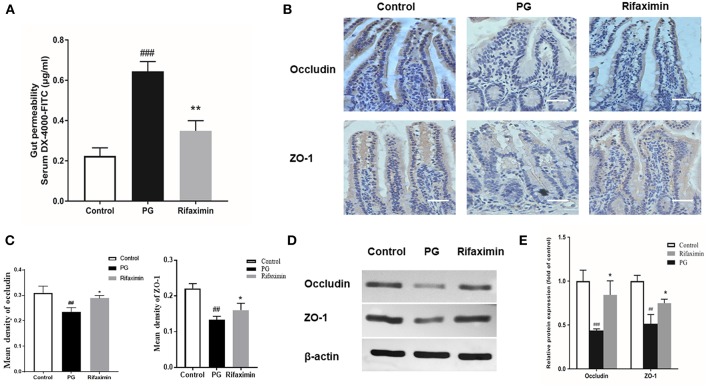
Rifaximin improves the intestinal mucosal barrier function in AS mice. (A) Gut permeability was measured by the DX-4000-FITC levels in the serum (n = 10 mice per group). (B) Occludin and ZO-1 protein in the ileum measured using immunohistochemistry. Occludin and ZO-1 positive cells were stained brown. The more intense the color, the higher the levels of occludin or ZO-1protein (Scale bar is 50μm). (C) Representative staining intensities of occludin and ZO-1 as designated by the mean optical density (n = 6 mice per group). (D) Representative western blots for occludin and ZO-1 proteins expressed in ileal tissue. (E) Protein expression quantified using densitometric analysis and was normalized to the levels of β-actin protein (n = 10 mice per group). Data are presented as means ± standard deviation (##P < 0.01, and ###P < 0.001 vs. control; *P < 0.05, and **P < 0.01 vs. PG alone).